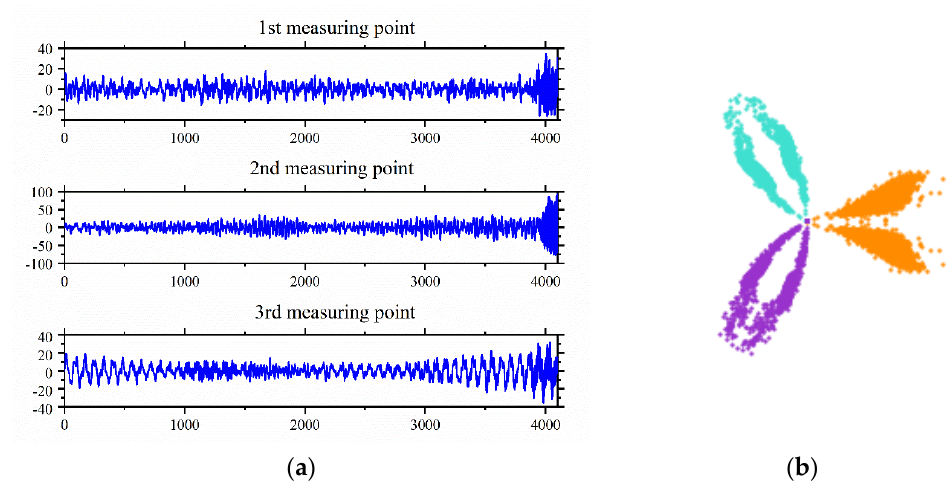
Figure 7. The SDP image under three measuring points; ( a ) Original vibration signal; ( b ) SDP image conversion.